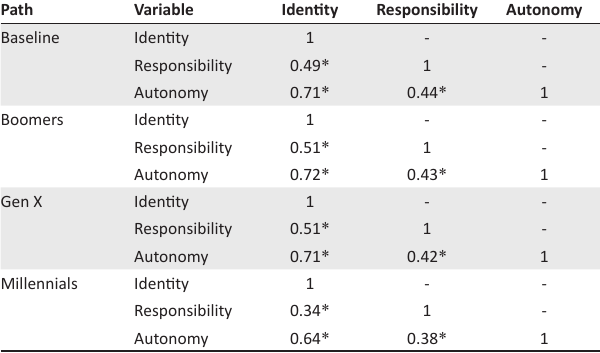
TABLE 6: Factorial